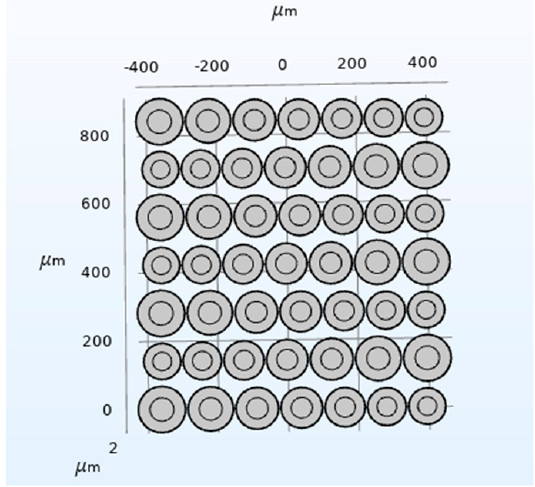
Figure 14. CMUT structure ( w = 20%).